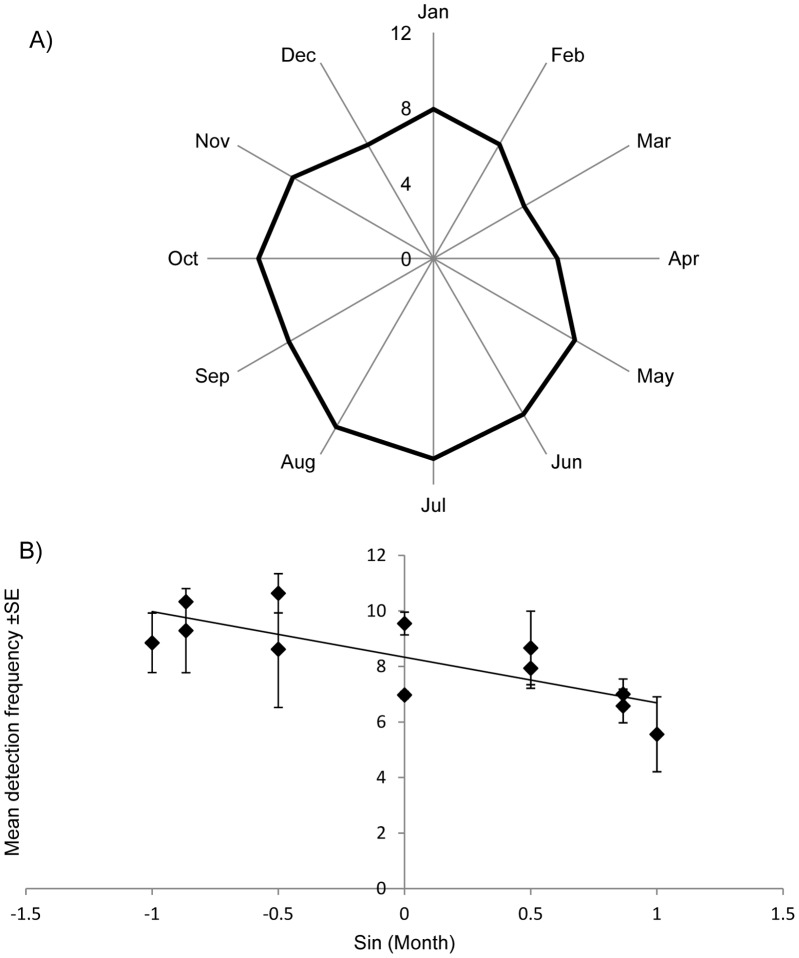
Mean detection frequencies of grey reef sharks per month in Palau.A) Polar plot of monthly mean daily detection frequency. Months are transformed and expressed as angles, mean daily detection frequencies in a given month (y-axis, areas combined) are represented as distance from the origin. Detection frequencies were corrected by the detection probabilities in each month, calculated from data of a control tag. B) Linear regression representing the mean daily detection frequency per month (areas combined) as a function of sin-transformed months. Equation y = −1.64x+8.33, R2 = 0.60.